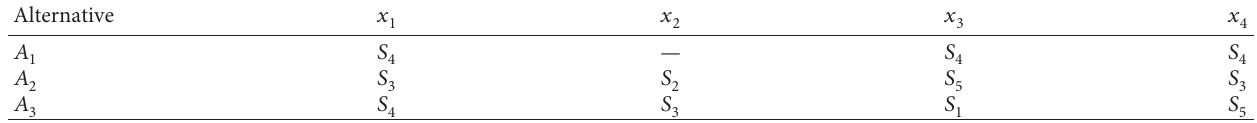
Table 23: The linguistic decision matrix provided by the third DM.